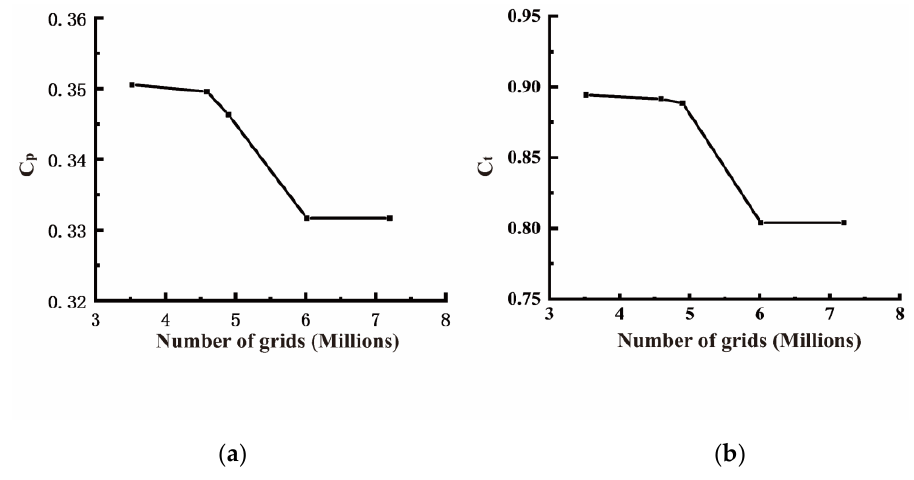
Figure 4. Grid-independence verification of fluid domain: ( a ) C p and ( b ) C t . Table 2. Grid-independent verification of solid domains.